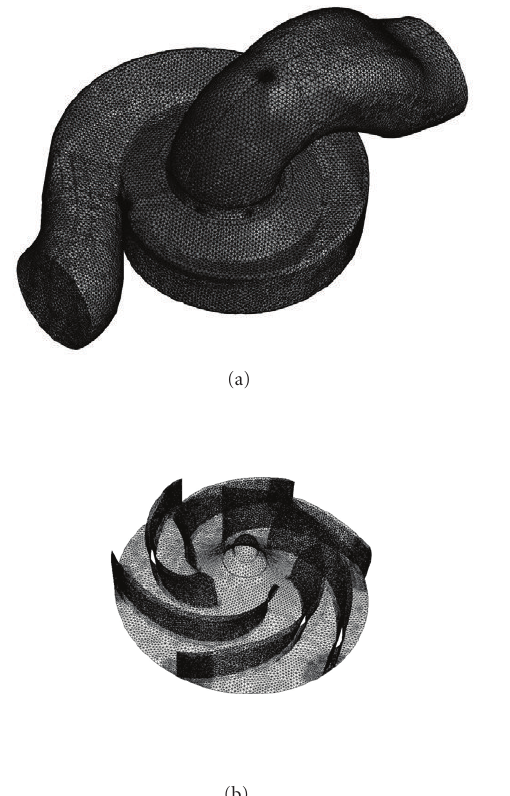
Figure 1: (a) Unstructured mesh for the centrifugal pump. (b) Im- peller mesh.